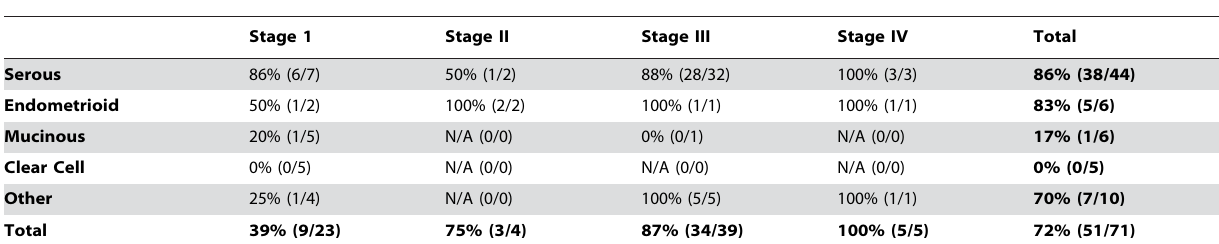
Table 5. Summary of correctly identified cases by histological